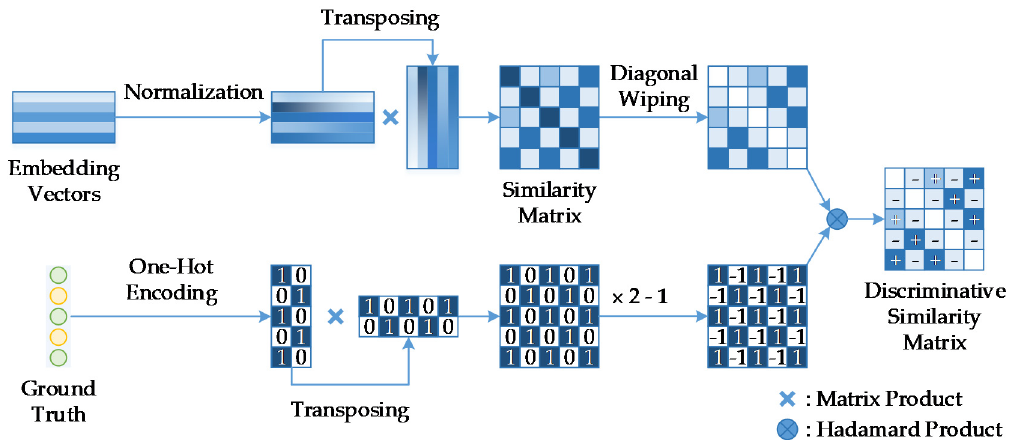
Figure 2. Diagram of calculation and analysis of the similarity matrix in the BSTriplet loss. The symbols “+” and “ − ” denote the similarities of positive pairs and negative pairs, respectively.